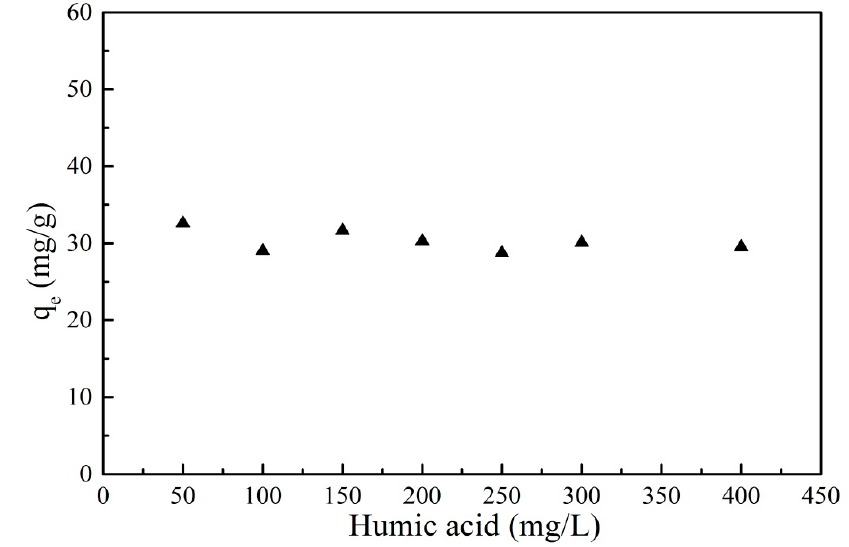
Figure 12. E ff ect of humic acid for PRO onto GO / Fe 3 O 4 ( C 0 = 25 mg / L, V = 20 mL, m = 0.01 g, t = 24 h, Figure 12. Effect of humic acid for PRO onto GO/Fe 3 O 4 ( C 0 = 25 mg/L, V = 20 mL, m = 0.01 g, t = 24 h, pH = pH = 7.5).